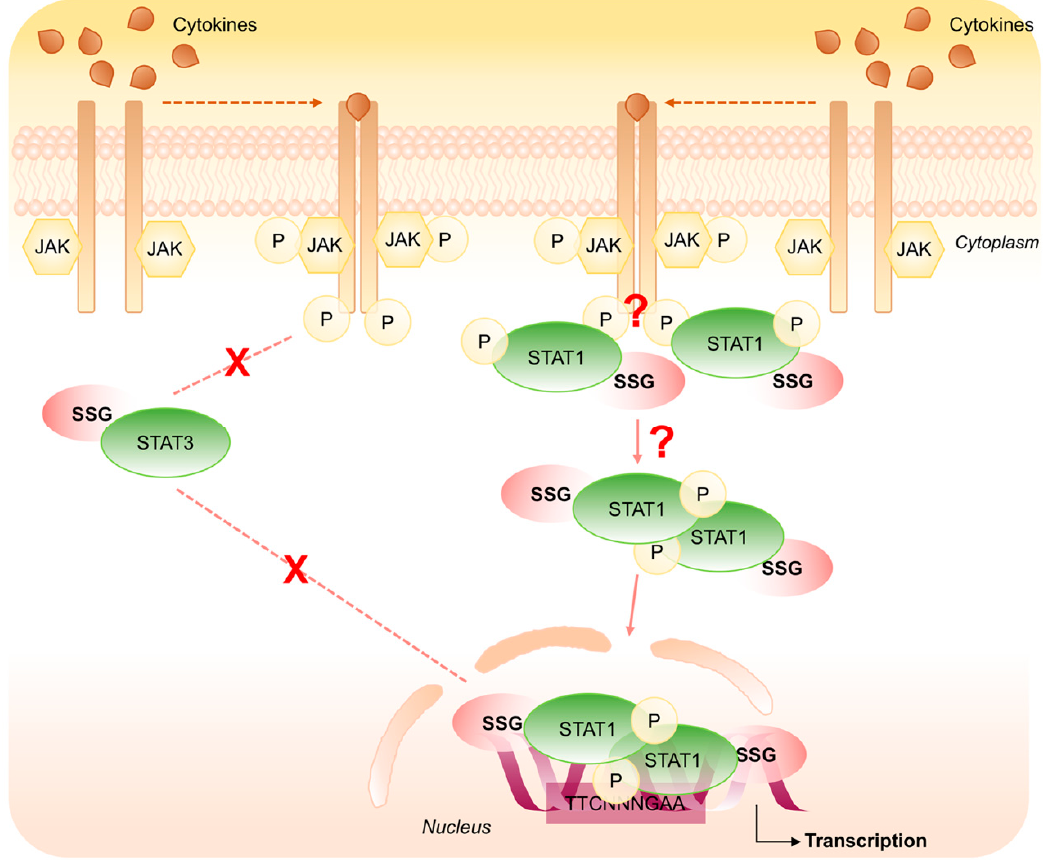
Figure 8. Schematic representation of the opposing role of S-glutathionylation on STAT1 and STAT3 signaling cascade. Oxidative stress induces STAT3 S-glutathionylation impairing its phosphorylation and down-regulating its signaling (dashed line). Conversely, oxidative stress induces both